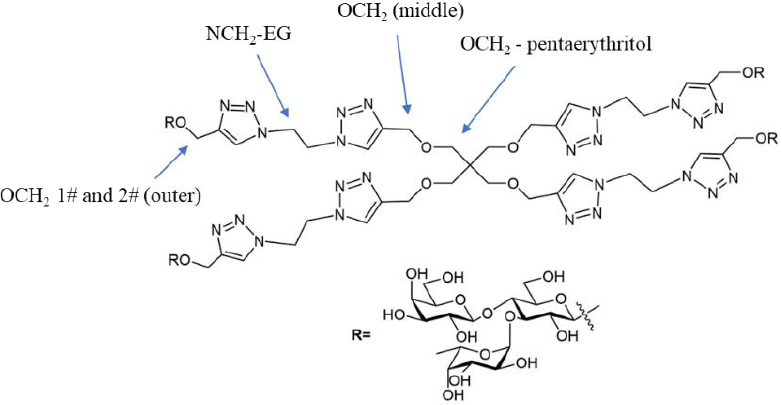
Figure 4. Structure of compound 8 and explanation of relevant structural moieties.